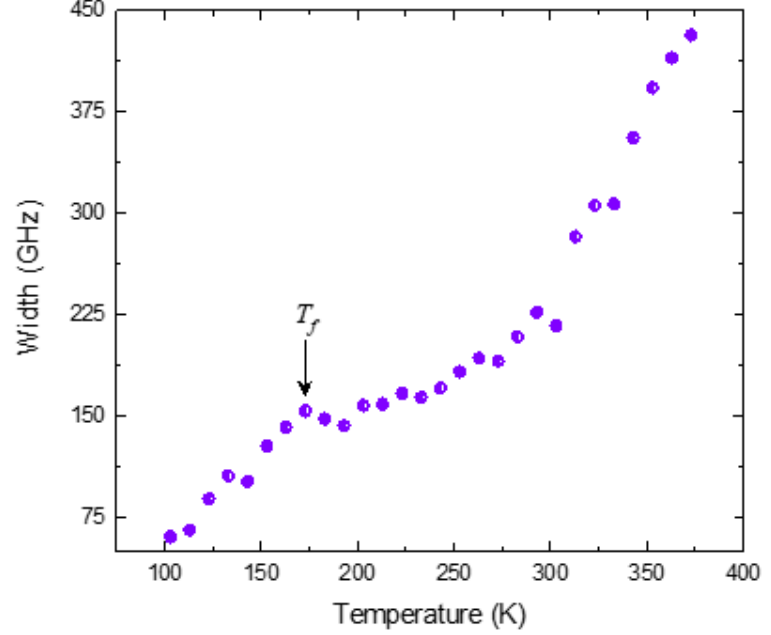
Figure 4. ( a – d )Typical broadband Brillouin spectra of PMT at ( a ) 293 K, ( b ) 273 K, ( c ) 253 K and ( d ) 223 K.The solid black line is the Lorentzian fit of the experimental data.